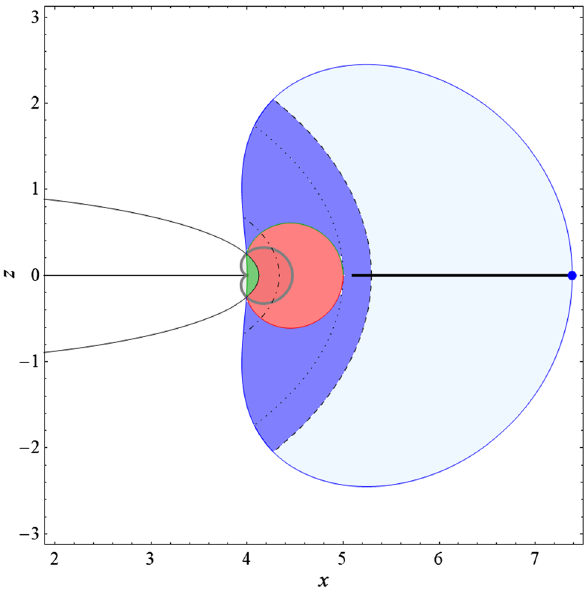
Fig. 19 EnlargementofpartofstructureoftheSPOsintheKNSspace- time with a = 4 corresponding to the Class VI. The spin axis is outside of the drawing. Note the reversed order of orbits r = 3 (black dotted) and r = r ms + (black dashed)